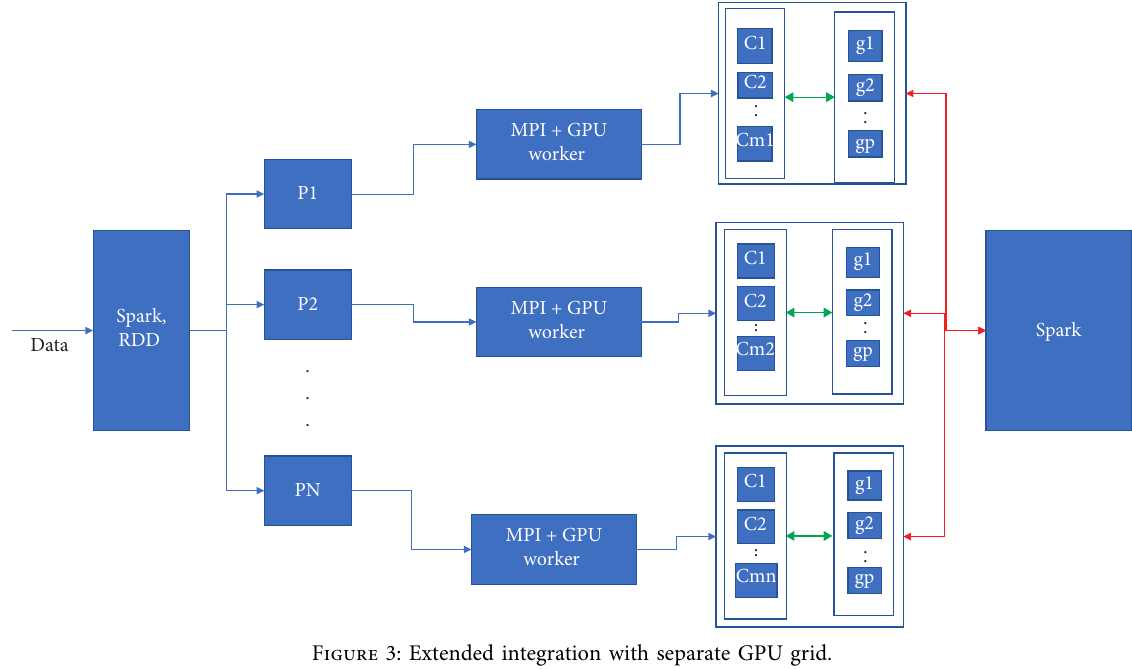
Figure 3: Extended integration with separate GPU